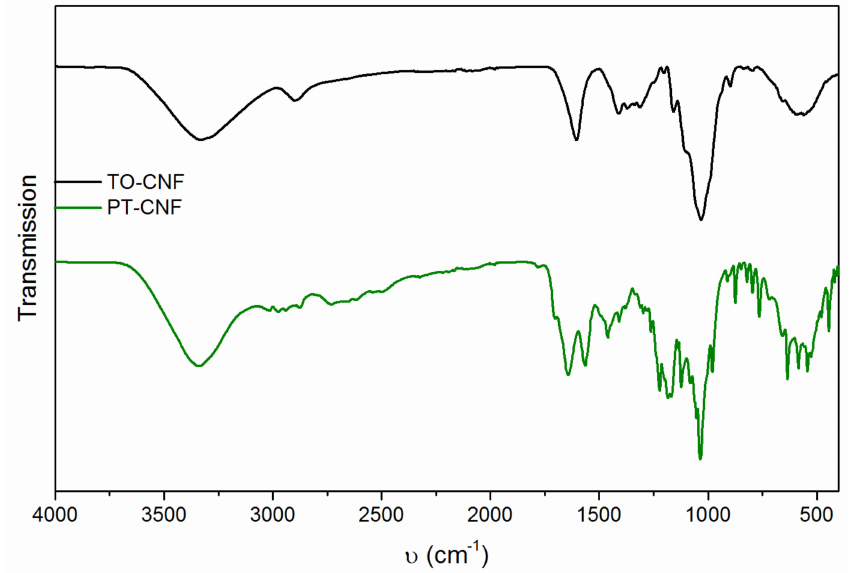
Figure 1. Fourier-transform infrared spectroscopy (FT-IR) spectra of (top, black) TO-CNF and (bottom, green)